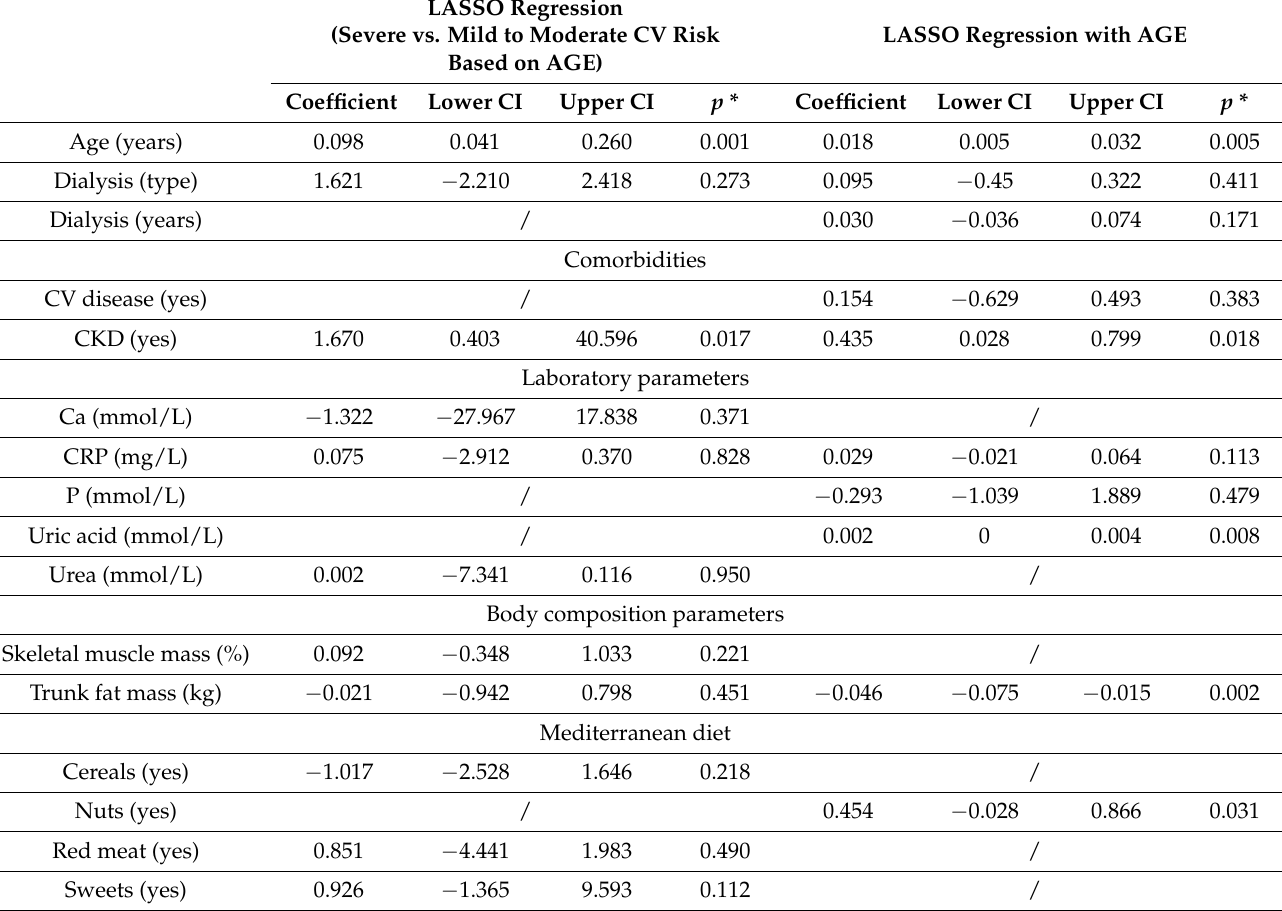
Table 3. Linear and logistic LASSO regression models to assess the predictors for severe CV risk based on AGE. LASSO Regression (Severe vs. Mild to Moderate CV Risk LASSO Regression with AGE Based on AGE) Coefficient Lower CI Upper CI p * Coefficient Lower CI Upper CI p